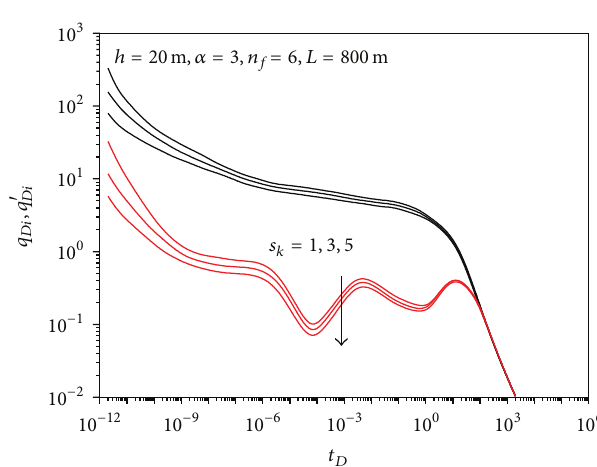
Figure 6: Effect of skin factor on type curves.